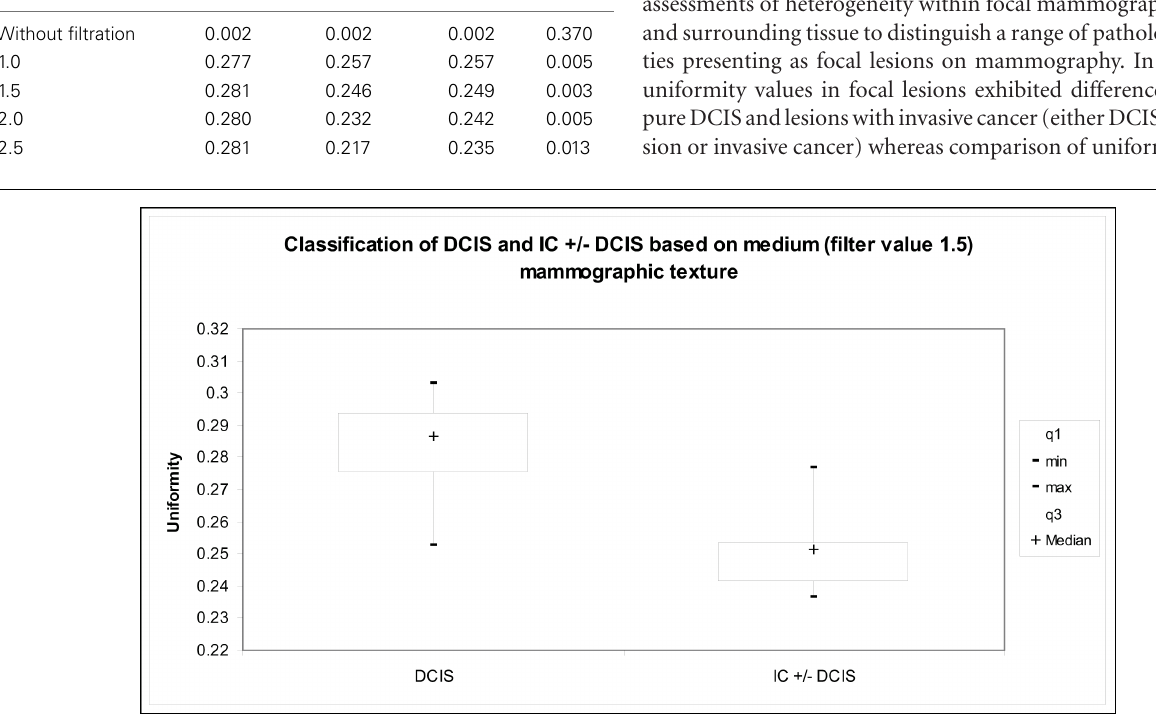
Frontiers in Oncology | Cancer Imaging and